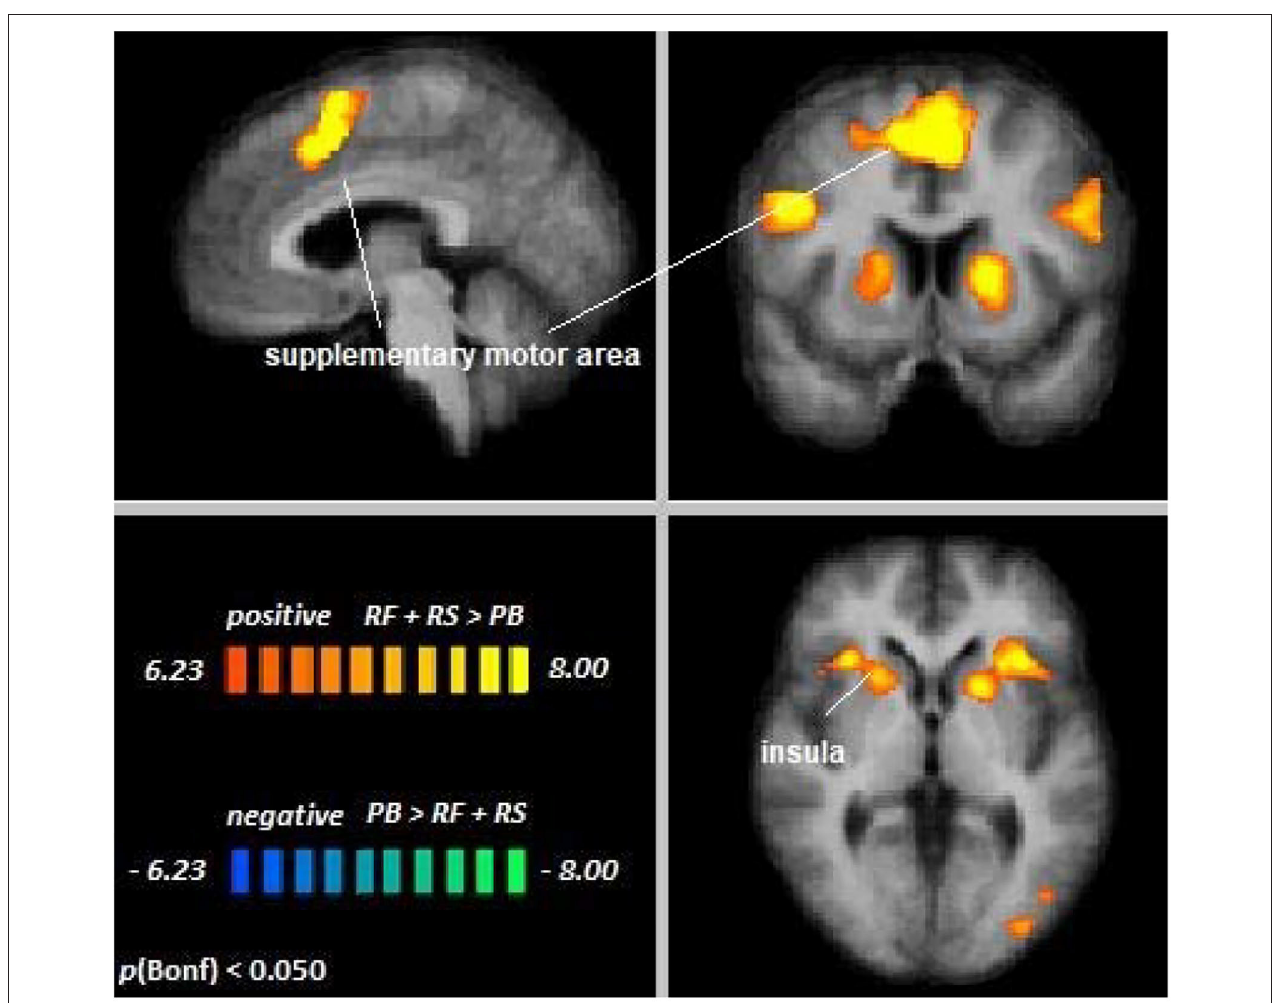
FIGURE 3 | Remember faces and remember scenes vs. passive baseline. An overview of significant clusters for the contrast RF + RS > PB. Sagittal, coronal, and axial planes are shown at x = 3, y = 6, z = 2. Active clusters indicate voxels with increased activation in visual selective attention conditions relative to baseline.